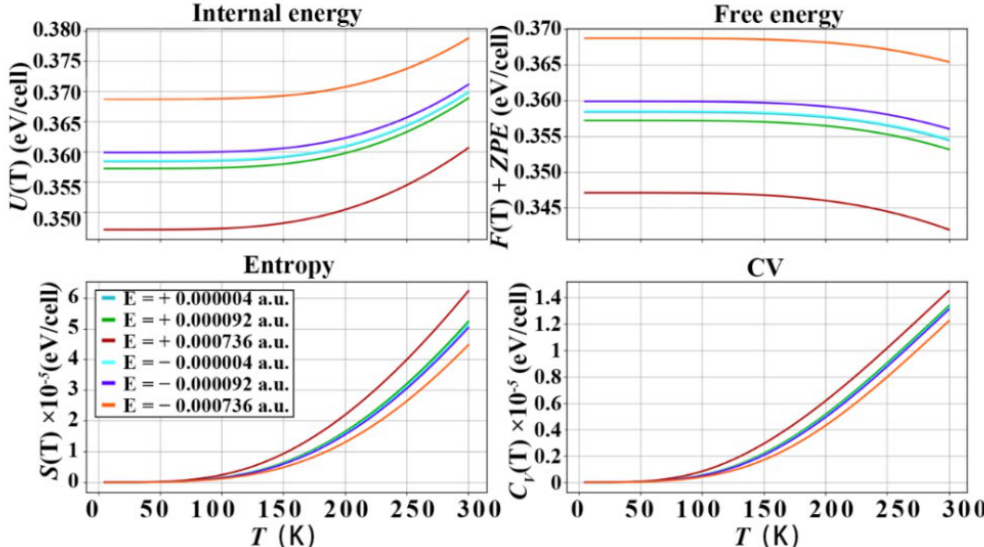
Figure 10. Thermodynamic properties of diamond, after applying different electric fields in the [110] crystallographic direction of diamond.